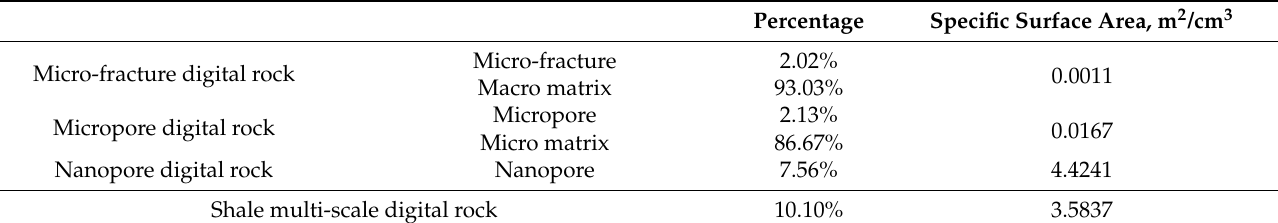
Table 1. Shale multiscale digital rock physical